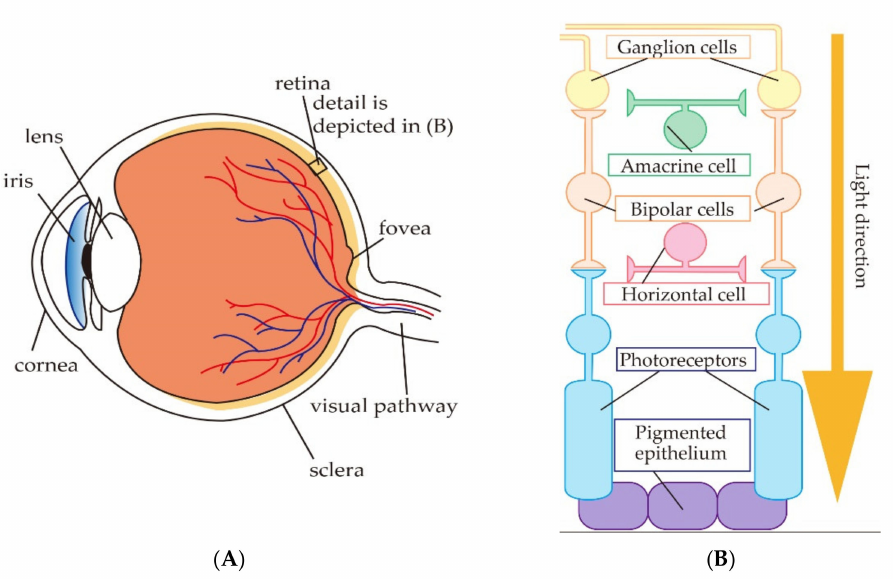
Figure 1. Internal structure of human eyeball: ( A ) Inside of the eye; ( B ) the organization of the retina. Moreover, from the report by Mihashi et al., it is clear that the electrical stimulus to the cornea does not flow to the eye orbit and does not stimulate the eyeball from the outer layer of the retina [20,21]. Injection of TTX (tetrodotoxin) into the eyeball inhibits the functions of ganglion cells and amacrine cells. Mihashi et al., injected it into the cat eyeball, applied light stimulus and electrical stimulus, and reported the activity of retinal cells. Figure 1B shows the organization of the retina. As shown in Figure 1B, the photoreceptors are located on the outer layer in the retina, and the ganglion cells and amacrine cells are located on the inner layer in the retina. Their report has clarified that the photoreceptors located in the outer layer of the retina did not respond to the electrical stimulus when the functions